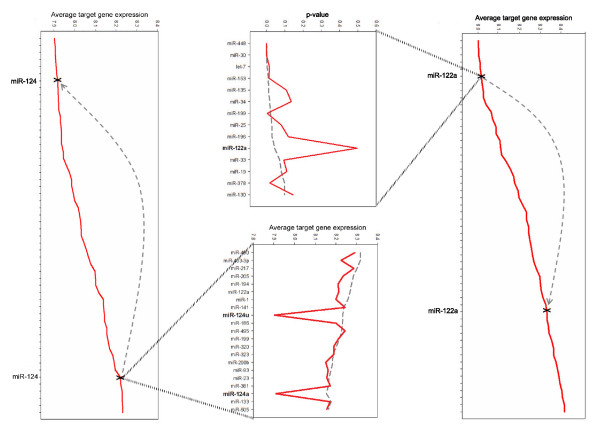
Detection of altered miRNA signatures following manipulation of miRNA expression. In the top and bottom panels miRNAs (x-axis) are ranked in order of average target gene expression (y-axis) with, for clarity, only miR-122a and miR124 labeled, respectively. Following inhibition of miR-122 by an antagomir [13] the position of the miR-122 average target gene expression in liver moved from the left to right of those for all ranked miRNAs (upper panel). This was reflected in a reduced probability (y-axis) that miR-122a predicted target genes were under-expressed, whilst all other miRNA effects remained relatively unaltered by the miR-122a antagomir (red versus dashed grey line in center left panel). Conversely, overexpression of miR-124 for 24 hours in the HepG2 cell line [12] caused miR-124 target gene expression to change from significantly highly over-expressed to significantly under-expressed (bottom panel). The selective drop in expression of miR-124 target gene expression is shown in the center right panel (this is apparent for the miR-122a and miR-122u isoforms present in the version of TargetScan used for this analysis). Whilst the data in this Figure are from analysis of mean absolute expression, the alternative methods produced similar results (data not shown).